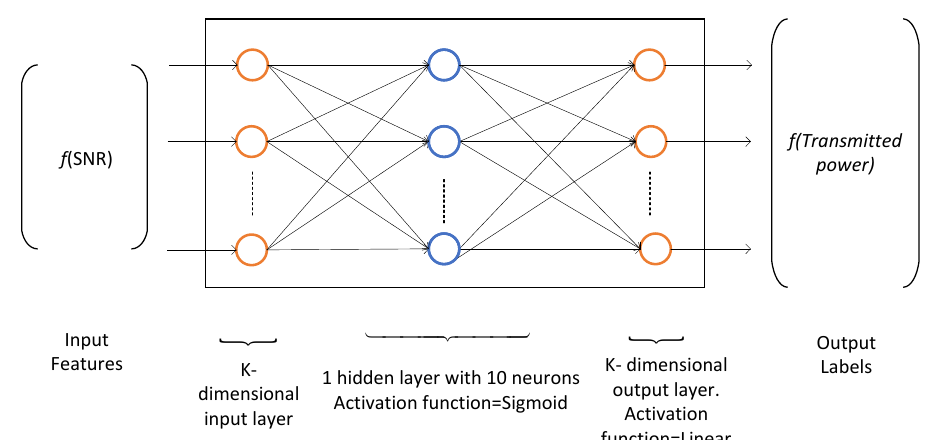
Figure 16. Neural network architecture for power allocation, K = 10.